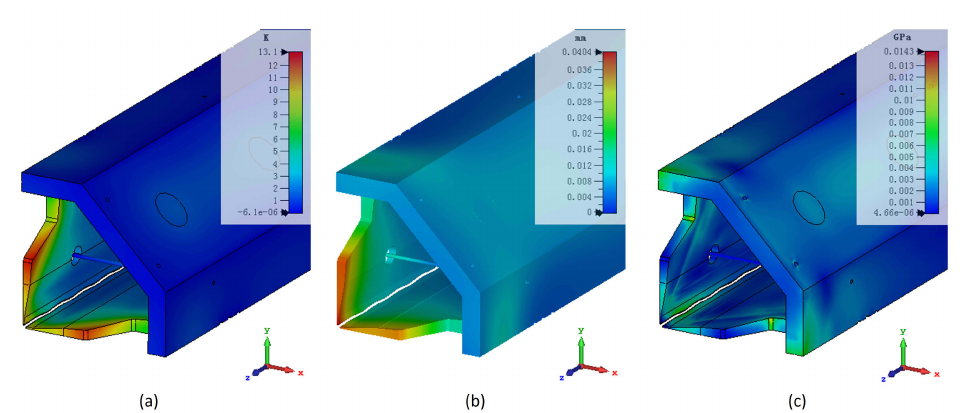
Figure 17. Simulation results of Multi-physics. ( a ) The temperature distribution of the cavity, ( b ) The deformation distribution of the cavity, ( c ) The thermal stress distribution of the